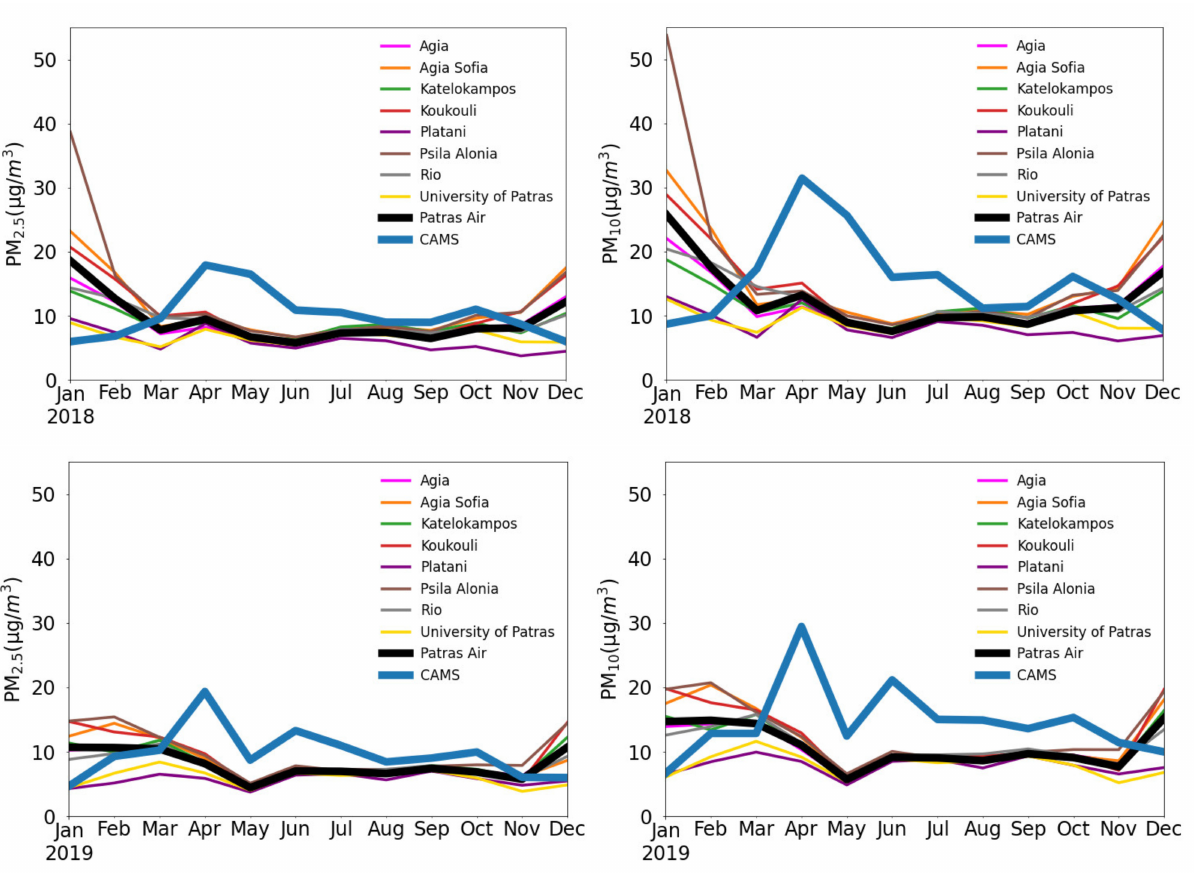
Figure 5. Monthly variations of the mean PM 2.5 ( left ) and PM 10 ( right ) concentrations in the eight monitoring stations during 2018 ( top row ) and 2019 ( bottom row ). The thick lines represent the observed and modelled concentrations at the CAMS scale (see text for